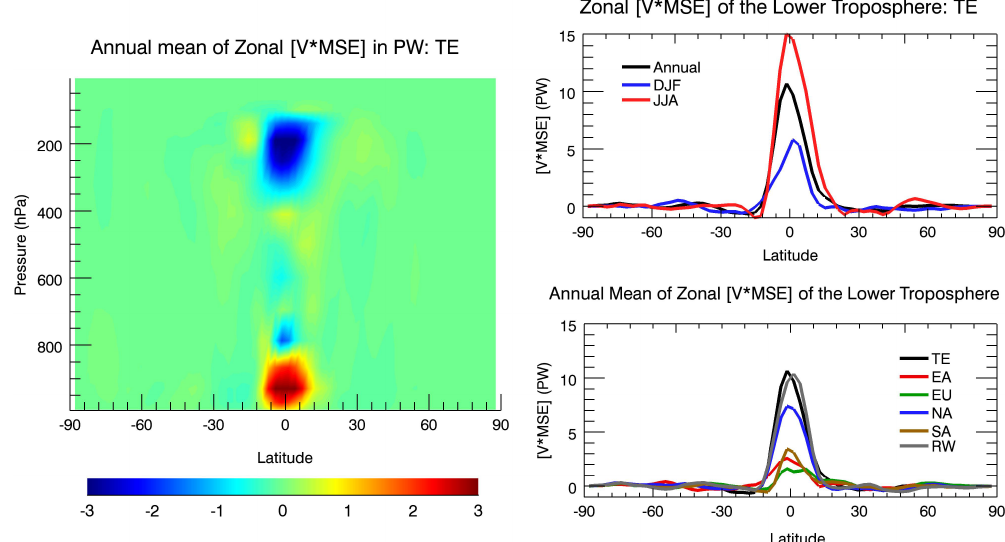
Fig. 4. Left panel: Zonal mean meridional flux of moist static energy (MSE) from the TE run. Upper panel on the right: Zonal mean meridional MSE fluxes as annual mean, December-January-February (DJF) mean, and June-July-August (JJA) mean, accumulated over the 4 lowermost model layers (from surface to ∼ 850hPa), derived from TE run. Lower panel on the right: Annual mean meridional MSE fluxes accumulated over the 4 lowermost model layers derived from different runs. Here: MSE = c p T + L v q + φ ; c p is the specific heat at constant pressure, L v the latent heat of vaporization, T the air temperature, q the specific humidity (water vapor mixing ratio), and φ the geopotential. The unit is in PW. All data are last 20-year means.